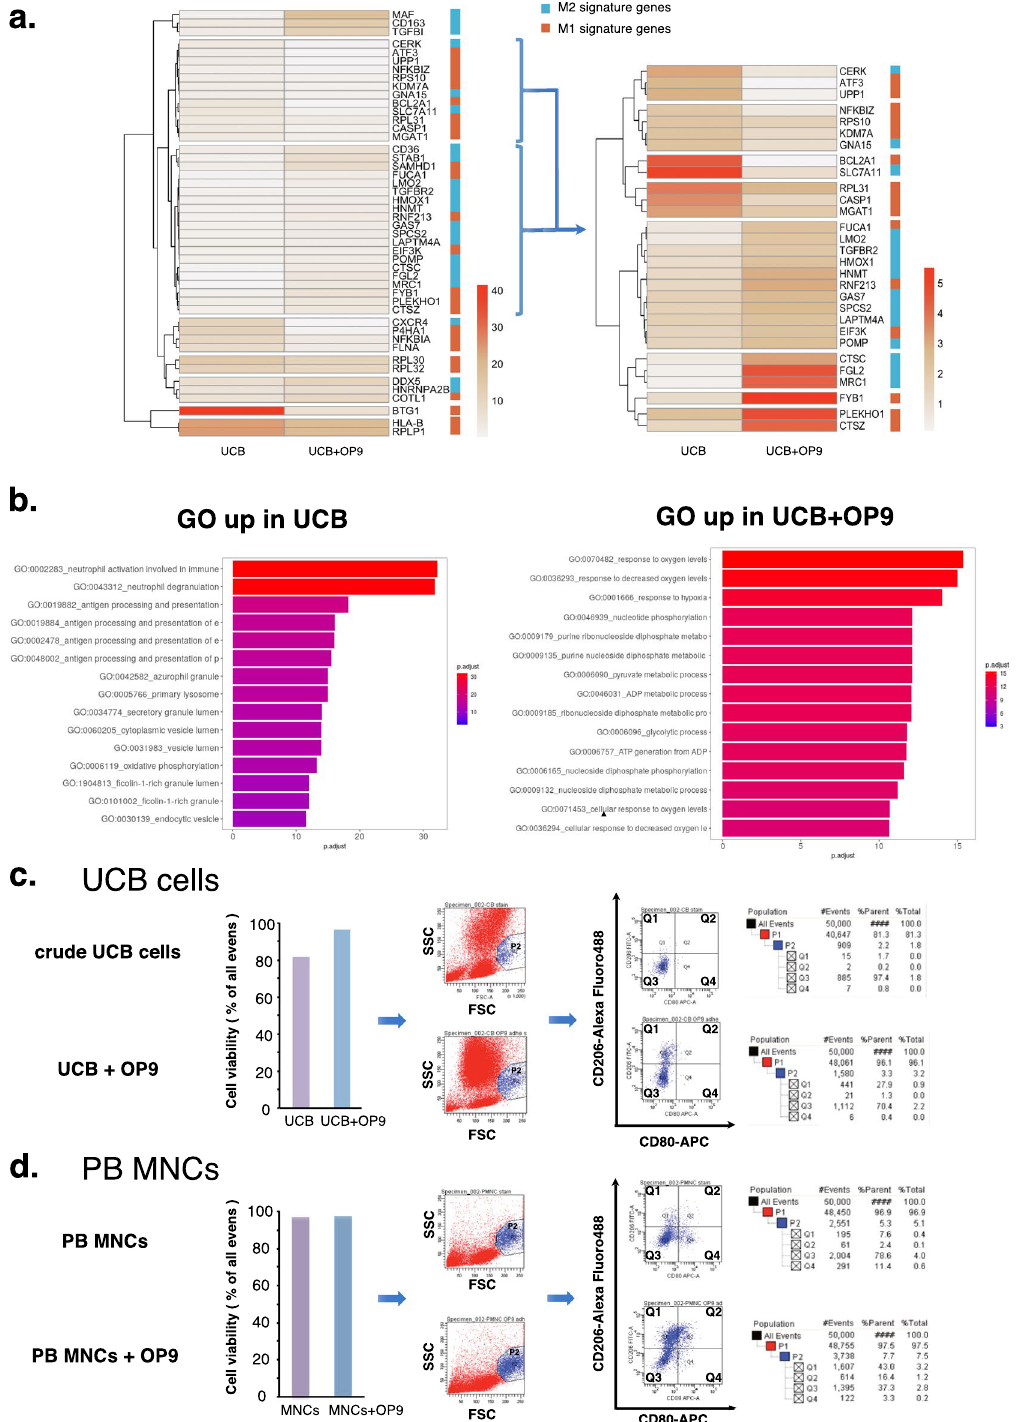
Figure 3. Single-cell RNA sequencing (scRNA-seq) and flow cytometry analysis of crude UCB and OP9 pre-conditioned UCB cells. ( a ) Heatmaps of typical M1 and M2 signature genes. Right sidebar depicts M1 and M2 signature genes in blue and red respectively. Scale bar indicates gene expression levels calculated from log normalized unique molecular index (UMI) counts (scale factor = 10,000). ( b ) Gene ontology (GO) enrichment analysis of differentially expressed genes between crude UCB and UCB + OP9. Enriched GO terms were identified based on the hypergeometric test and adjusted p values were derived by the Benjamini and Hochberg (BH) method. Top 15 enriched GO terms were shown according to –log10 p value. ( c , d ) Flow cytometry analysis of UCB and UCB + OP9. Cell viability (the ratio of living cells to all events) was analyzed using DAPI staining. Cells in monocytic fraction (P1 population) were gated based on forward angle light scatter (FSC) and side angle light scatter (SSC) characteristics. Then, CD80 and CD206 were used to sort M1 and M2 type cells into Q4 and Q1 quadrants,